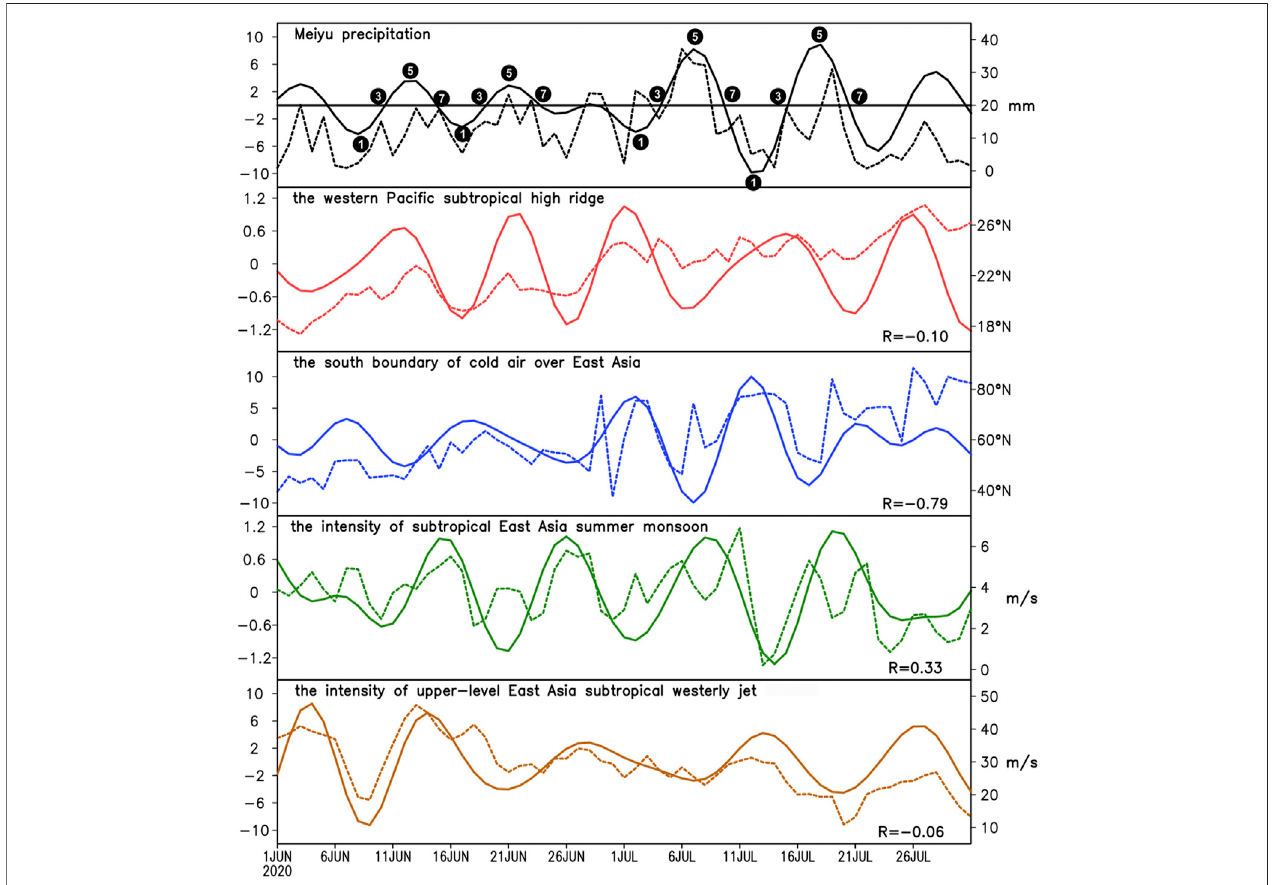
FIGURE 8 | 8-16-day Lanczos fi lter value (solid curves, left axes) and daily original value (dashed curves, right axes) of Meiyu precipitation, WPSH ridge, southern boundaryofcoldairoverEastAsia,intensityofSEASM,andintensityofupper-levelEastAsiasubtropicalwesterlyjetfromJune1,2020,toJuly31,2020(numbersof “ 1, ” “ 3, ” “ 5, ” and “ 7 ” denote different phases of four processes of QWBO component during 2020 Meiyu season).